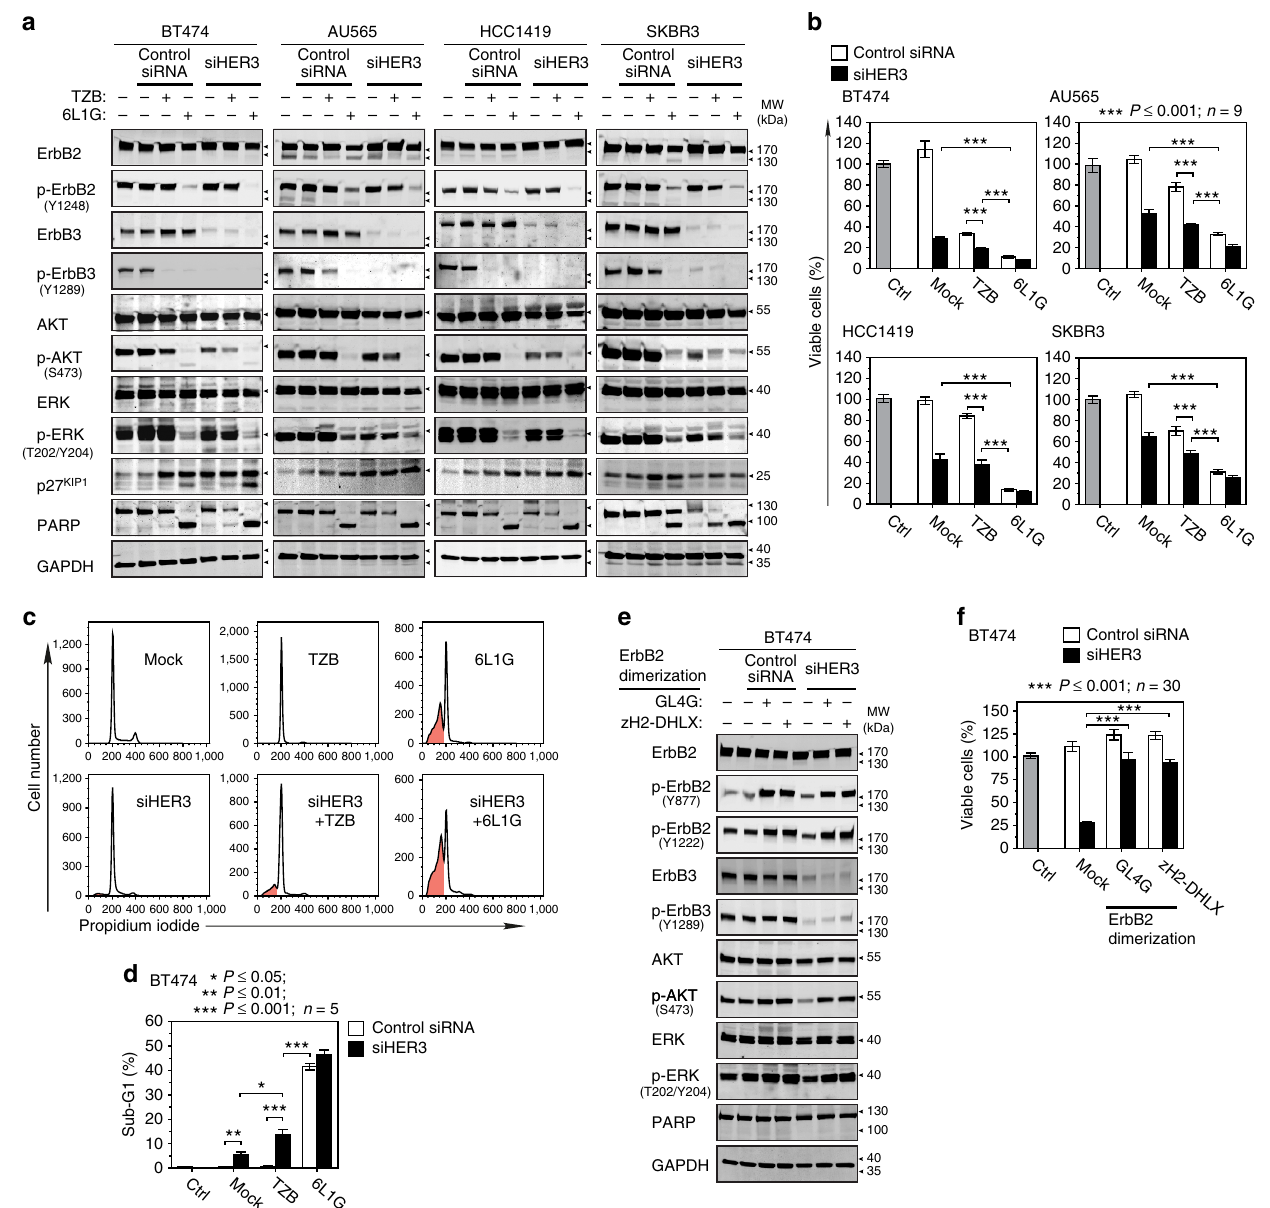
Figure 7 | ErbB3 knockdown is not sufficient to induce apoptosis without inhibition of ErbB2. ( a – d ) Phosphorylated ErbB2 in the absence of ErbB3 receptor expression correlates with AKT reactivation and is sufficient to suppress apoptosis in ErbB2-dependent cancer cells. Inhibition of receptor signalling ( a ), proliferation ( b ), cell cycle ( c ) and apoptosis ( d ) 72h after ErbB3 knockdown by siHER3 alone or in combination with 100nM TZB or 6L1G (Supplementary Fig. 4C–F) (* P value in b Mann–Whitney test; data in d are mean ± s.e.m.,* P value in d two-sided, unpaired Student’s t -test). ( e , f ) Stimulation of p-AKT ( e ) and restoration of cell proliferation ( f ) in BT474 cells with simultaneous ErbB3 knock down and hyperactivation of ErbB2 homodimers with 50nM of GL4G (G3-L4-G3) or zH2-DHLX (zHer2-L2-DHLX). Homo-bivalent GL4G or zH2-DHLX stimulate ErbB2 dimerization and consequently ErbB2 phosphorylation and downstream signalling to p-AKT ( e ) and finally rescue the growth inhibitory effect of siHER3 in XTT assays (Mann–Whitney test). Consistent with these findings, lonafarnib as well as tipifarnib, concurrent decoupling of AKT from p-ErbB3/p85/p110 by another RAS FT inhibitor, potentiated the cytotoxic activity of trastuzumab together with RAS/p110 inhibition by tipifarnib. trastuzumab (Fig. 8b), and the RAS inhibitor/trastuzumab To validate the significance of RAS—p110 a interaction for the combination became as efficient in inducing apoptosis as the crosstalk between p-ErbB2 and PI3K, we made use of intracellular biparatopic agents (Fig. 8c). Importantly, the gain of cytotoxic RAS-binding proteins (Supplementary Fig. 5B), either blocking activity directly correlated with the inhibition of AKT the RAS-RBD binding interface (RAS104, RAS107) or not re-phosphorylation (Fig. 8d,e). Since tipifarnib as single agent interfering with the interaction with p110 (RAS109). Accordingly, did not substantially influence p-AKT levels in ErbB2-over- the cells carrying RAS104 and RAS107 showed significantly expressing cells, we deduce that the synergistic inhibition of higher susceptibility to trastuzumab treatment than the cells with p-AKT by tipifarnib and trastuzumab was the consequence of no RAS interference (Fig. 8f). Furthermore, we silenced RAS NATURE COMMUNICATIONS|7:11672|DOI: